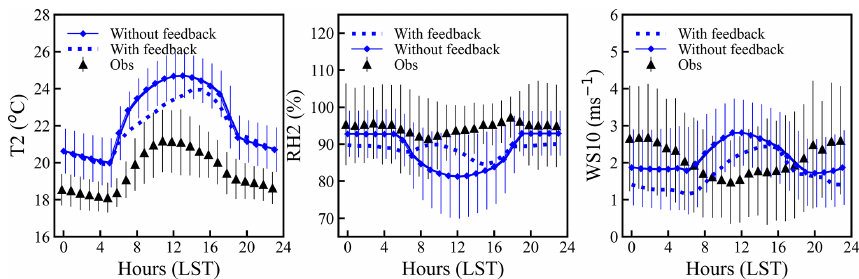
Figure 9. Diurnal variation of the T 2, RH2, and WS10 from d01 without feedback (WRF-WF) and with feedback (WRF-F). The bars represent the standard deviation and are shown only for domain d01 and observations in order to avoid overlap.